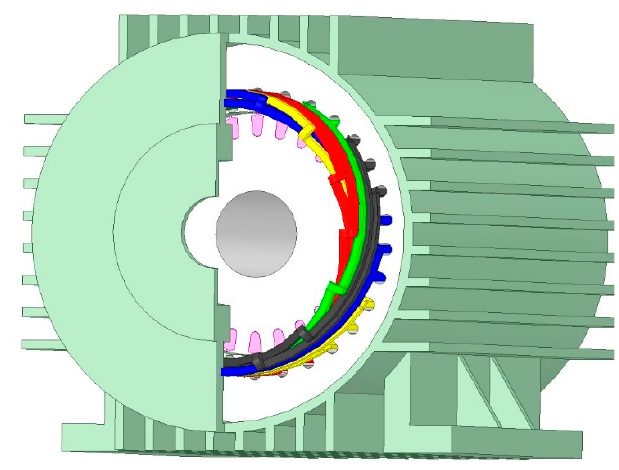
Figure 1. Model of five-phase cage induction motor.